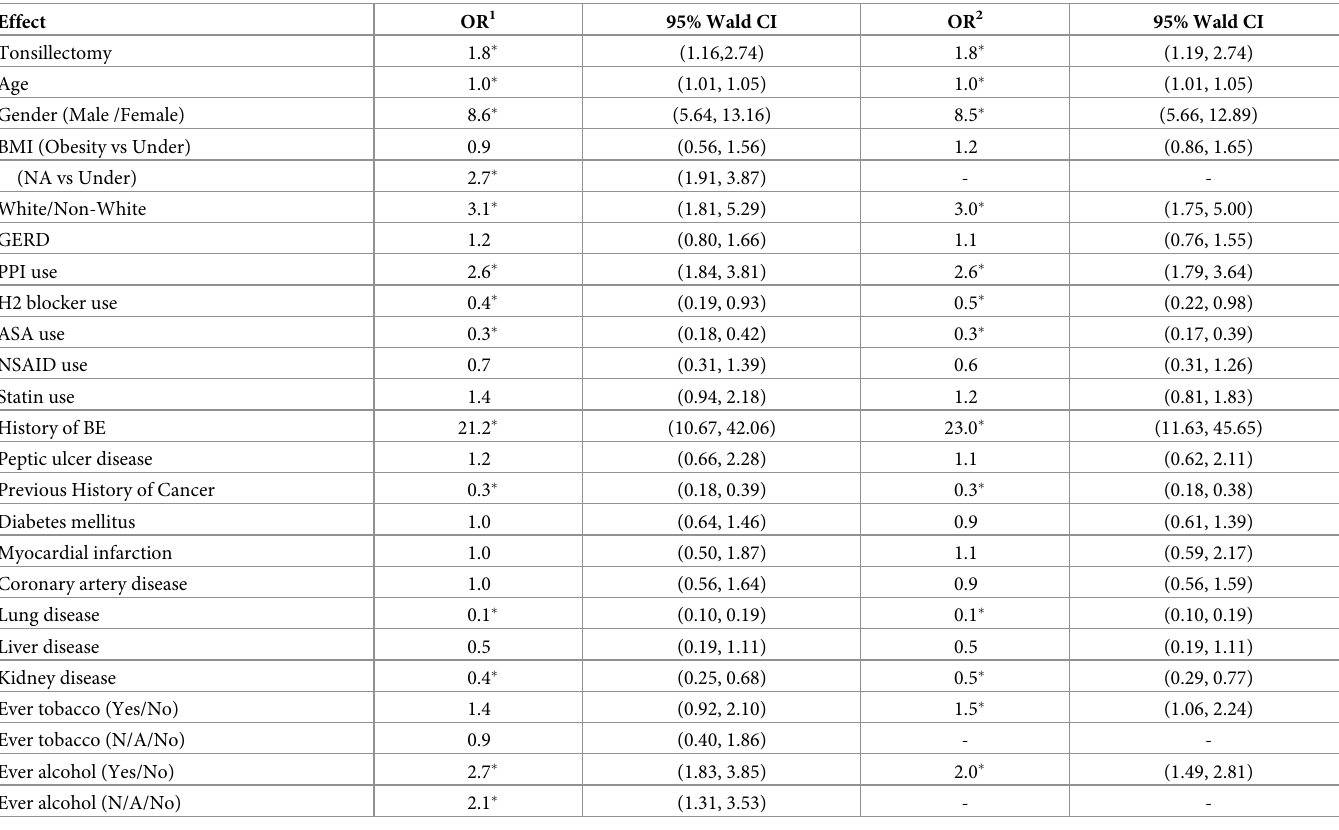
Table 4. Multivariate logistic regression to evaluate associations between tonsillectomy, esophageal adenocarcinoma, and other covariates. Two ORs are presented for each variable: 1) Before imputation of missing values (BMI, tobacco, alcohol); 2 After imputation of missing values.